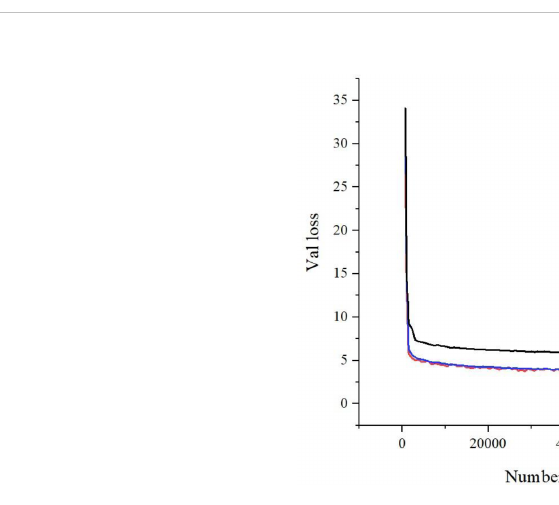
FIGURE 7 Model training loss value change trend